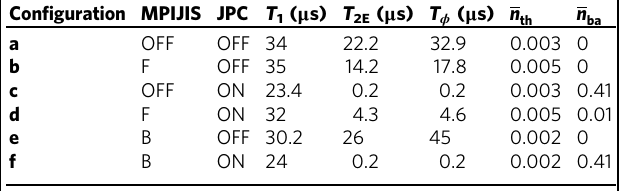
are quite similar to con fi guration c . This is because in both cases the isolator is not shielding the qubit against excess backaction of the preampli fi er (JPC).